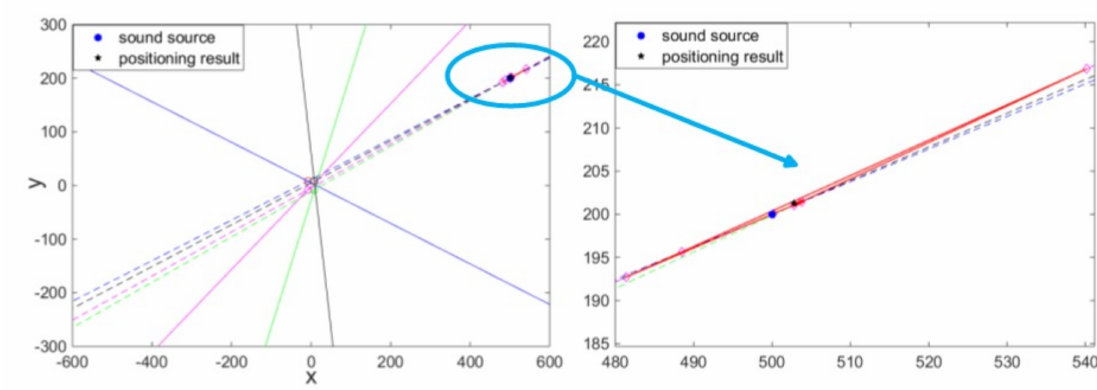
Figure 15. The positioning test results at (500,